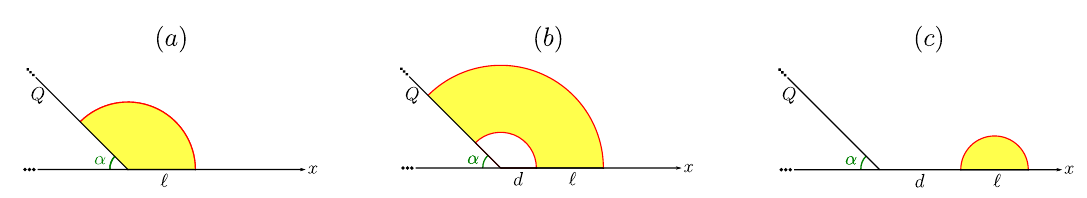
Figure 5 . RT surfaces and corresponding spacetime regions relevant for the subregion complexity of an interval of length ‘ . In (cid:12)gure (a) the interval is attached to the boundary. In cases (b) and (c) it is at (cid:12)nite distance d from the